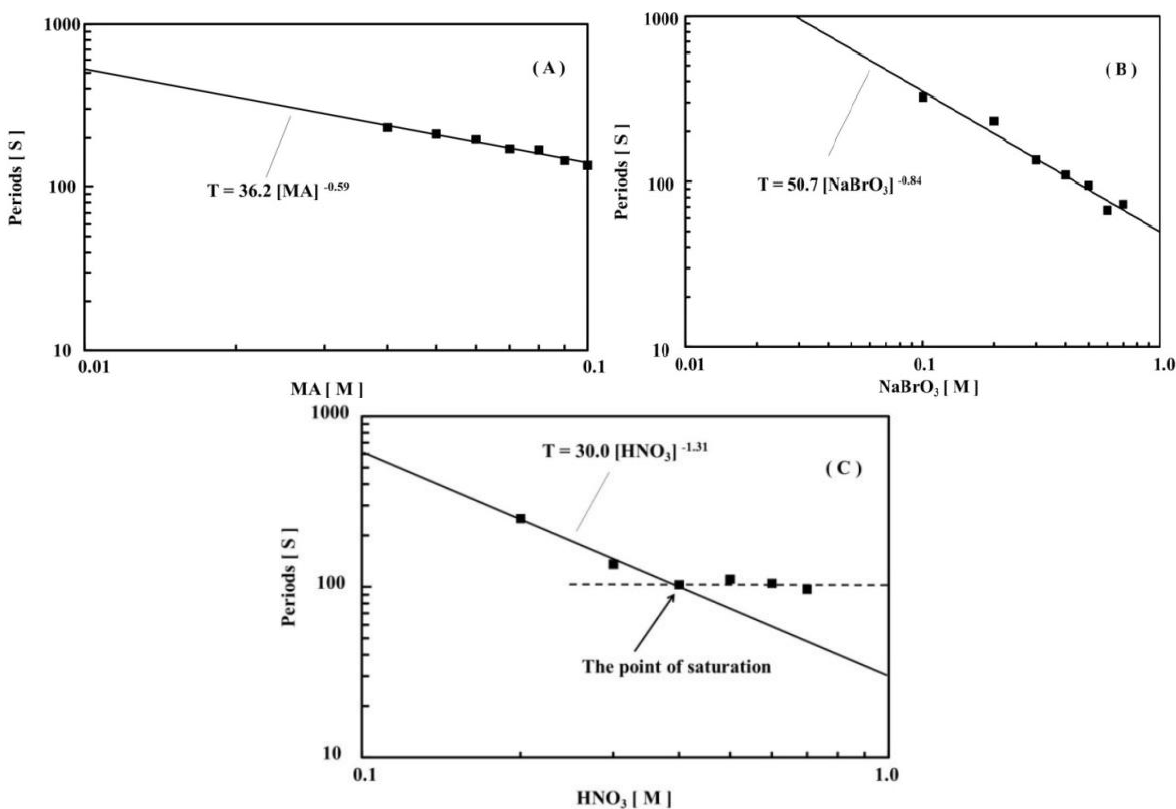
Figure 7. Logarithmic plots of period T (in s) vs. initial molar concentration of one BZ substrate at a constant temperature ( T = 20 °C) under fixed concentrations for the other two BZ substrates: ( A ) [NaBrO ] = 0.3 M and [HNO ] = 0.3 M, ( B ) [MA] = 0.1 M and 3 3 [HNO ] = 0.3 M, and ( C ) [MA] = 0.1 M and [NaBrO ] = 0.3 M. 3 3